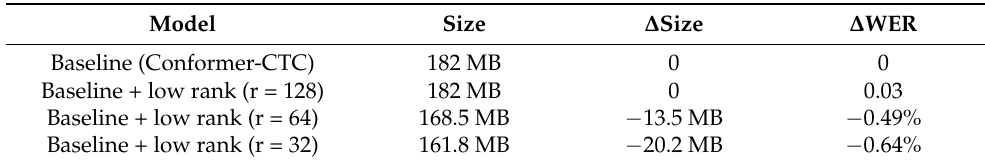
Table 3. We used Conformer as the baseline model and then compared the decomposition results of different rank sizes.